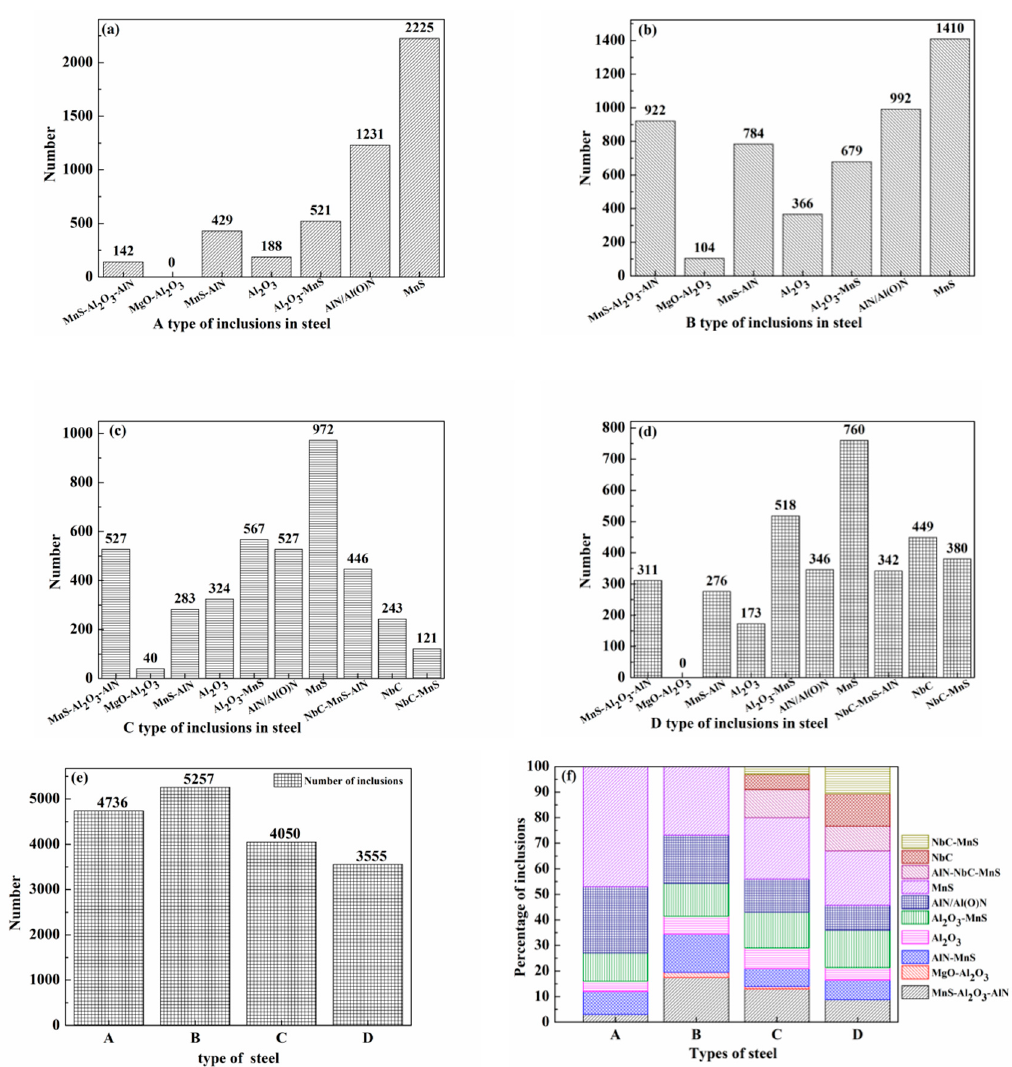
Figure 5. The proportion of inclusions in TWIP steel with different numbers of inclusions and different heats: ( a ) is the number of different inclusions in steel A, ( b ) is the number of different inclusions in steel B, ( c ) is the number of different inclusions in steel C, ( d ) is the number of different inclusions in steel D, ( e ) is the total number of inclusions in different heats, and ( f ) is the proportion of different inclusions in different heats.